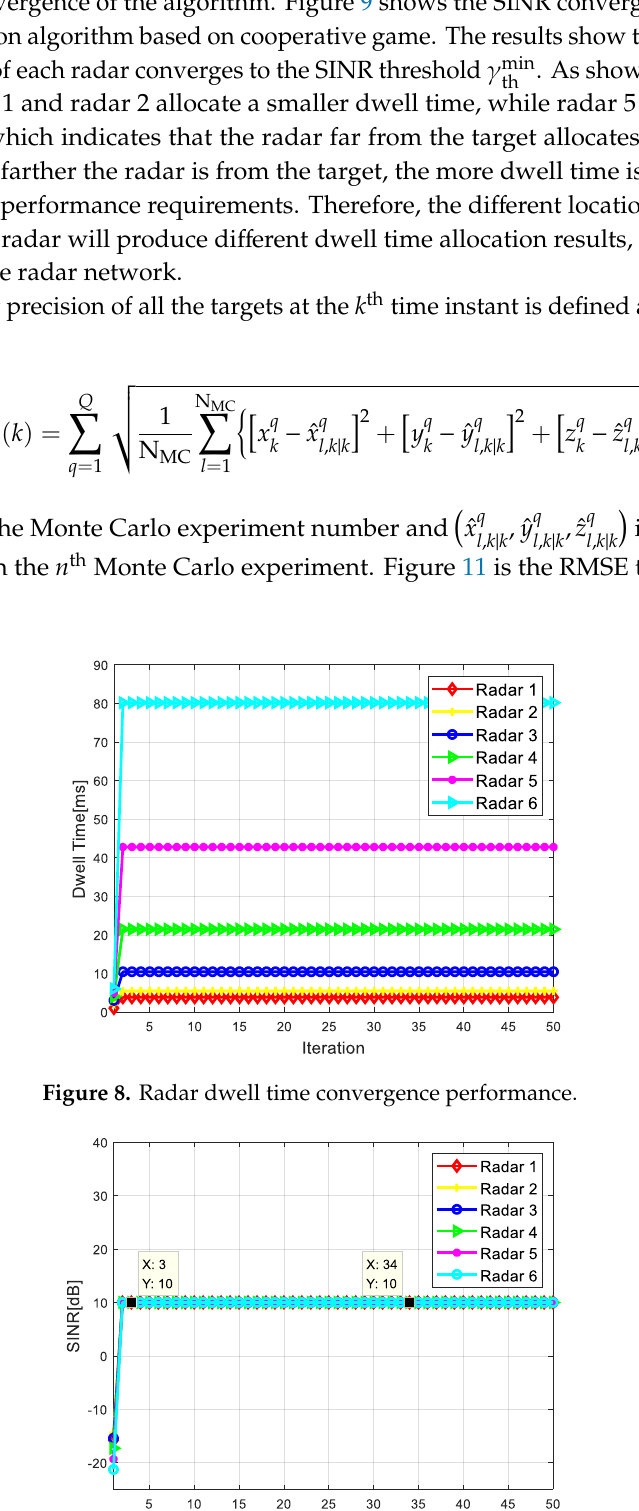
Figure 10. Target 1 radar dwell time allocation ratio.